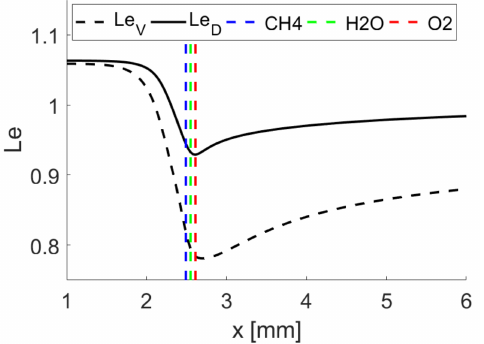
Figure 4. Effective Lewis number versus axial position. Vertical dashed lines represent the location of reaction progress variable value c = 0.8 based on species CH 4 ,H 2 O,O 2 mass fraction. Results are taken from laminar flame simulations of a stoichiometric methane-air